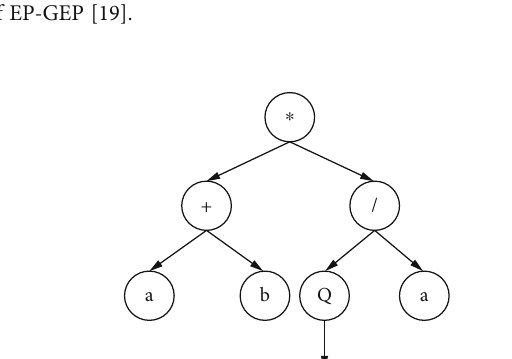
Figure 1: Flowchart of EP-GEP [19].